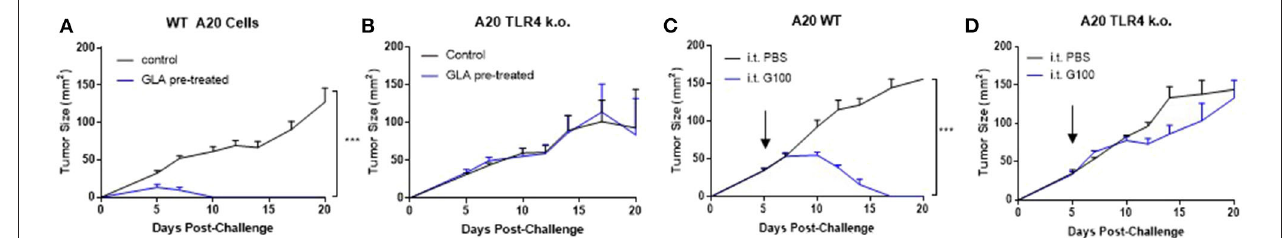
FIGURE 4 | GLA has anti-tumor effects in A20 WT but not A20 TLR4 ko tumor cells in vitro and in vivo . (A,B) Pre-treatment with GLA-AF (incubating cells in medium containing GLA-AF (5 µ g /ml) in vitro for 48h prior to subcutaneous implantation in mice inhibited the growth of wild type (WT), but not TLR4 knockout (k.o.) A20 tumor growth after inoculation. (C,D) IT G100 treatment inhibited the growth of WT but not TLR4k.o. A20 tumors. IT injection of G100 (10 µ g GLA-SE, 3x/week) started on Day 7 after the tumors were established and lasted for 3 weeks. Shown are average tumor sizes (mean ± sem) for each treatment groups ( N = 5/group). *** p < 0.001 by student t-